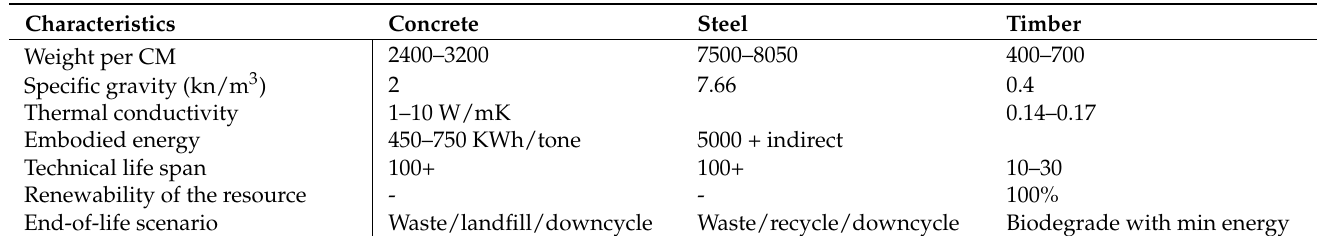
Table 6. A comparison of technical characteristics of present days’ BI market